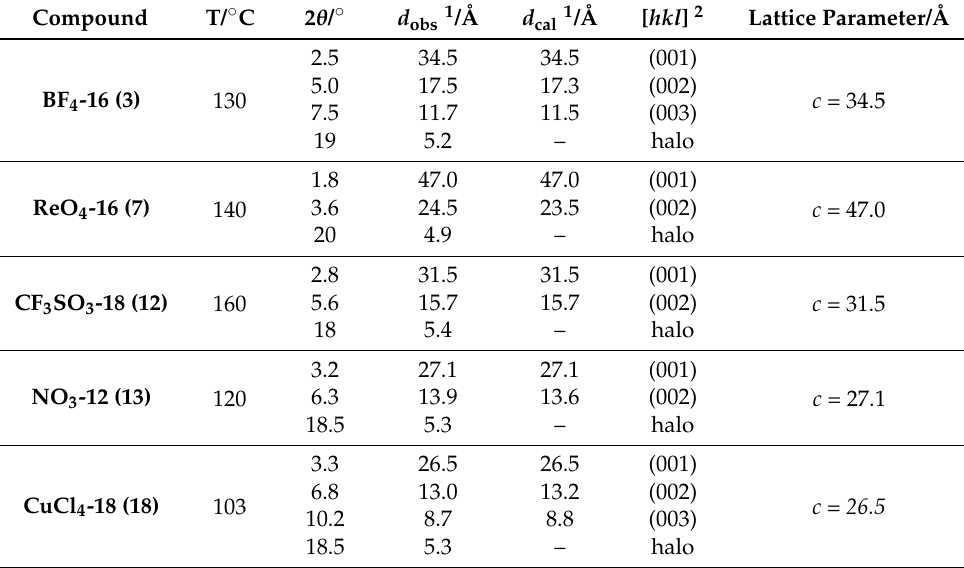
Table 3. X-ray diffraction data of selected compounds.